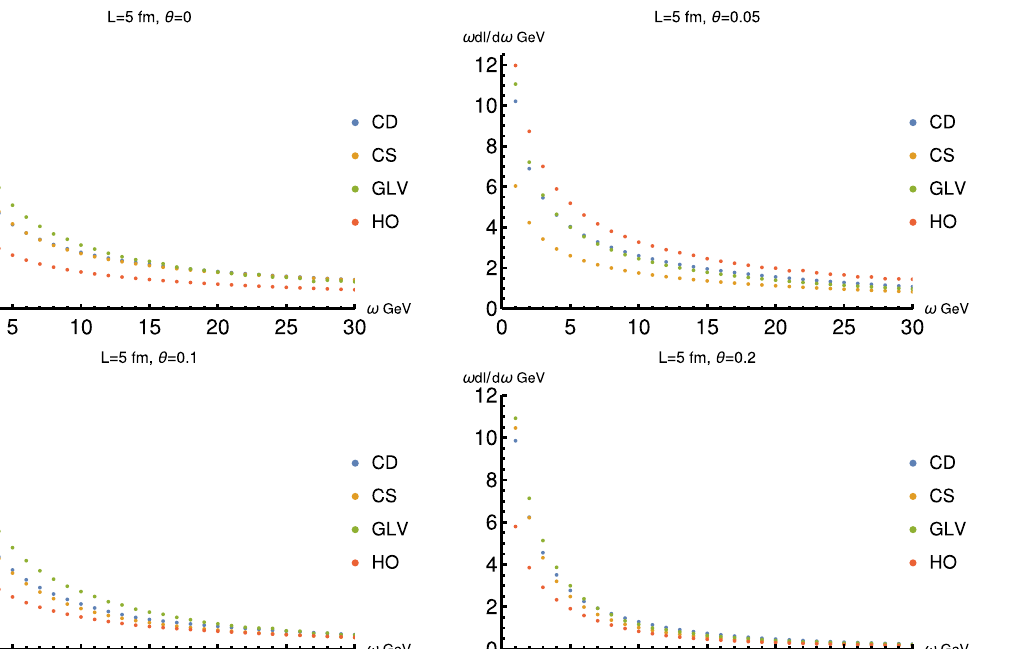
of order 100 GeV (i.e. θ ∼ 0 . 05 the quenching coefficients are actually the same for light quark and heavy